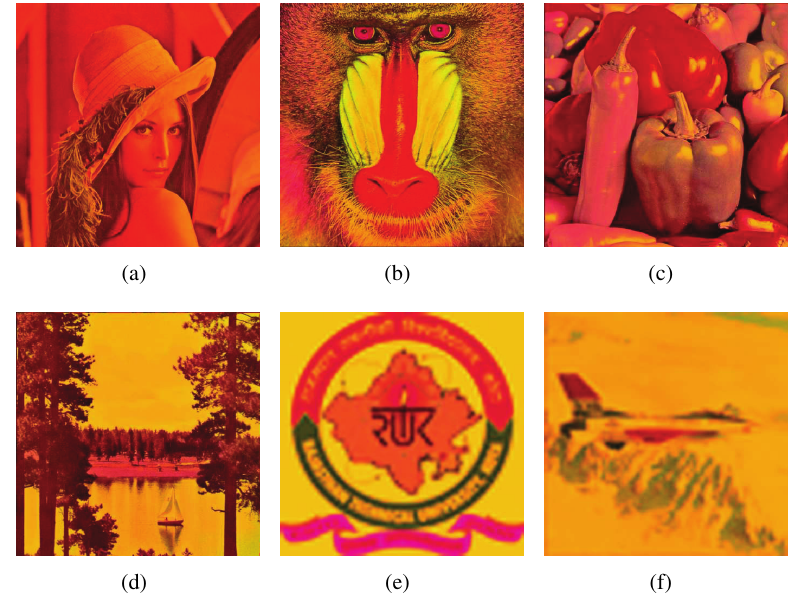
Figure 7: UCS host and watermark images (a). Lena, (b). Mandrill, (c). Pepper, (d). Sailboat, (e). RTU Logo, and (f). Aeroplane.